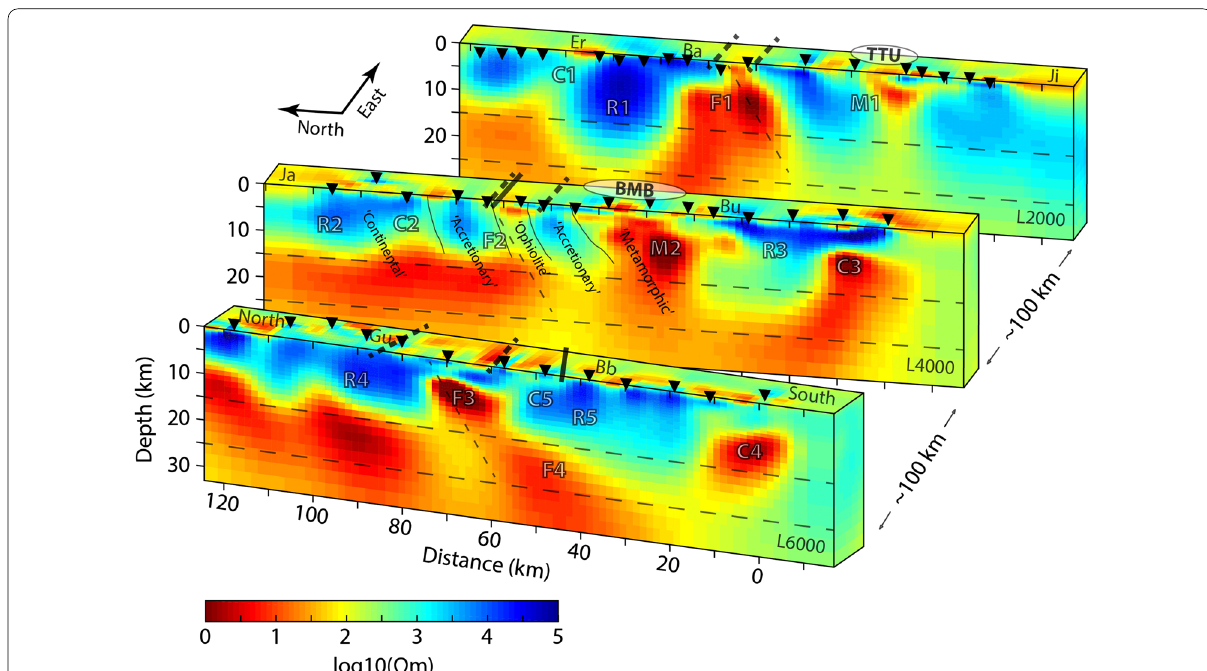
Fig. 7 The preferred 3-D electrical resistivity models. The models, along three profiles (L2000, L4000, and L6000), were obtained with the MODEM inversion algorithm (Kelbert et al. 2014). The locations of MT measurement sites are indicated with black triangles. Distances are along the profiles, from south to north, along longitudes of approximately 98.5 °E, 99.7 °E, and 100.7 °E (see Fig. 1). Black lines correspond to the South Hangai fault system (solid) and to the Bayankhongor Ophiolite Belt (dashed; see Fig. 1), which are related to a major crustal boundary and ancient suture zone. Anomalous features in the upper crust appear coincident with surface fault/suture positions (e.g., F1, F2, and F3). Fault/suture extension in the subsurface (dashed grey lines) is speculated, and is intended only to illustrate down-dip features. The locations of several prominent mineralized zones are marked (BMB: Bayankhongor Metal Belt; TTU: Tsagaan Tsahir Uul and Saran Uul). They are coincident with low-resistivity anomalies in the shallow upper crust (M1 and M2). Highly resistive features in the north are attributed to a continental block north of the ophiolite belt and suture zone (Hangai; R1, R2, and R4). Conductive features C3 and C4 are of unknown origin. Geological units, and their contacts, are labeled on profile L4000 from the congruent cross-section of Osozawa et al. (2008). Villages are labeled as in Fig. 1. Note that the crust is believed to be 45 km to 50 km thick. Horizontal dashed lines denote the approximate depths of the upper crust, midcrust, and lower